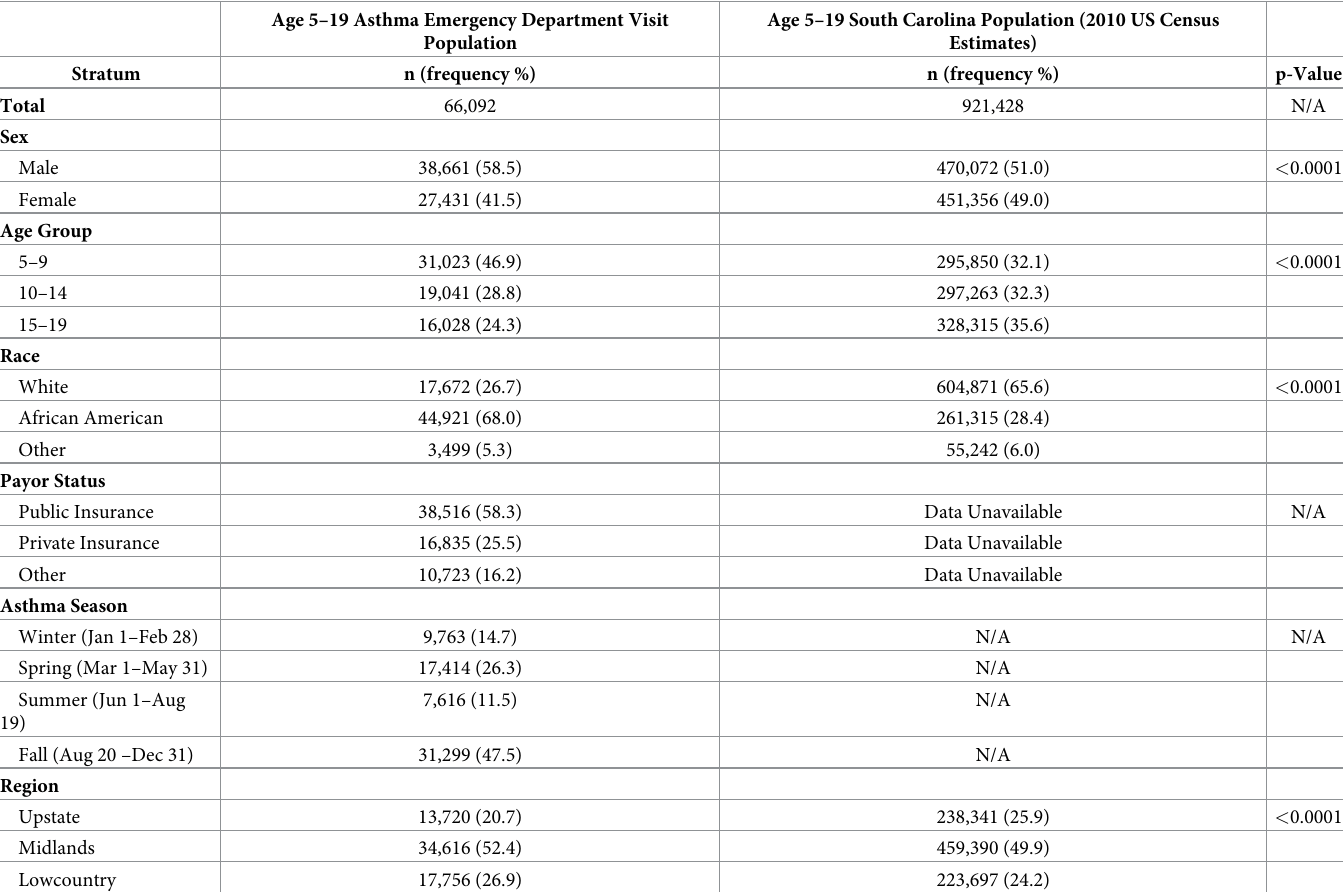
Table 1. Population characteristics of the age 5–19 year populations that used the emergency department (ED) for asthma from 2005 to 2014 and for the state of South